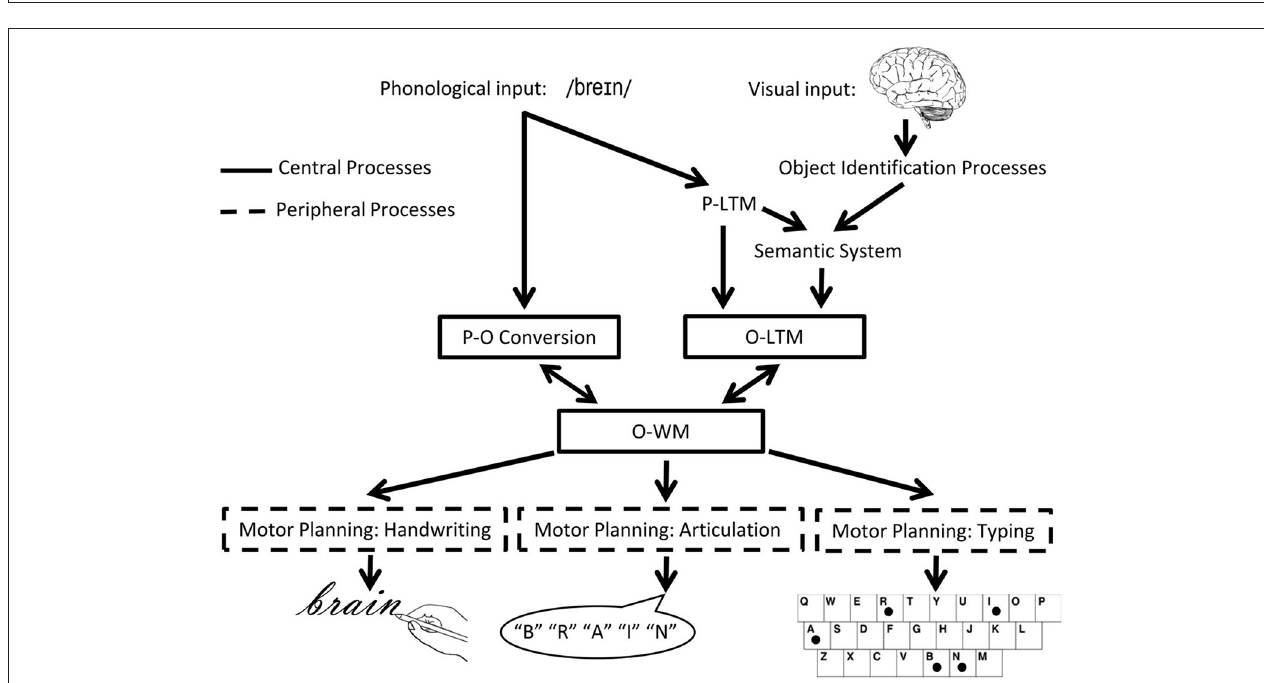
FIGURE 2 | The cognitive architecture of spelling. Schematic depiction of the cognitive processes involved in spelling, highlighting central (core) and peripheral processes. P, phonological/phonology; O, orthographic/orthography; WM, working memory [adapted from (22)].